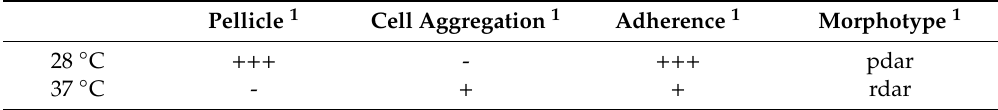
Table 1. Biofilm characteristics of E. ludwigii CEB04.